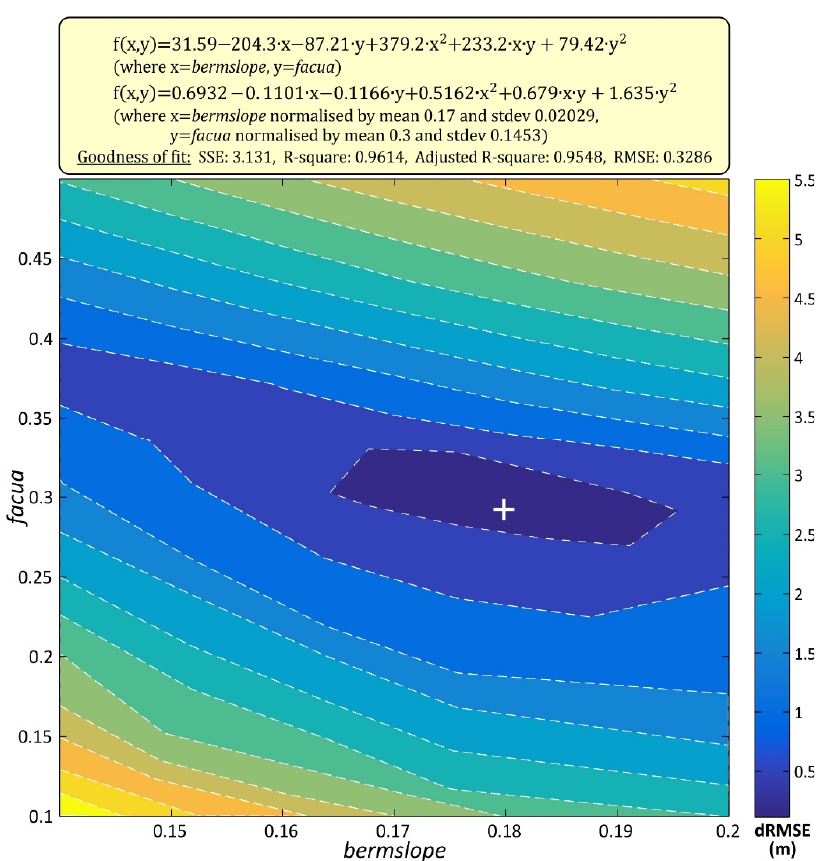
Figure 9. Increase of RMSE (dRMSE in m; color-scale) with bermslope and facua with respect to the calibration run (cross); all combinations were simulated for profile PE and the recovery period (8 March to 20 April) and the dRMSE values shown refer to the end of the simulation (20 April). A second order polynomial equation is fitted to the values (on top).